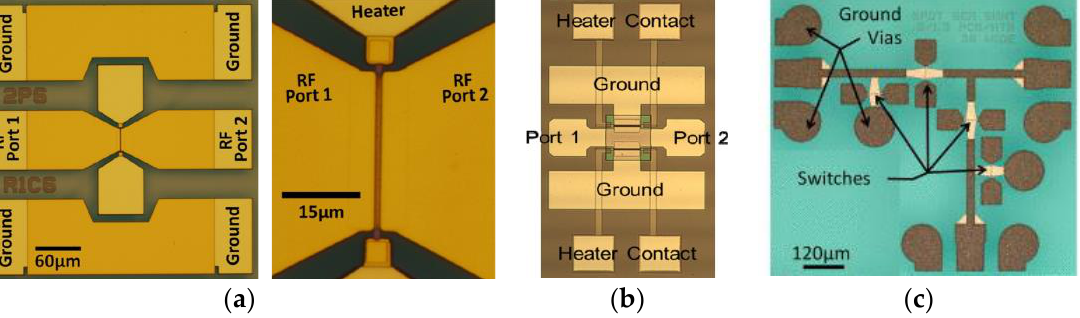
Figure 3. Optical micrographs. ( a ) PCM RF series switch [11]; ( b ) GeTe RF shunt switch [15]; ( c ) GeTe RF SPDT switch [11].